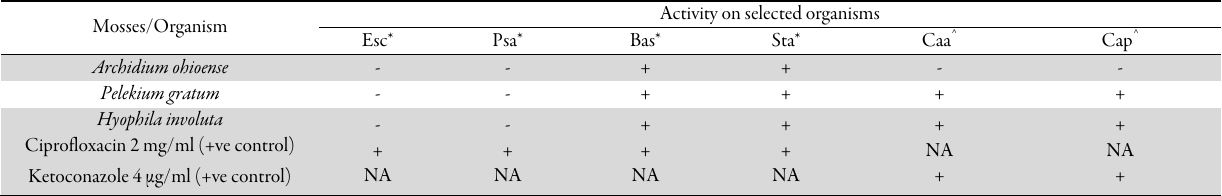
Table 3. Screening of antimicrobial activity of the schnapp extracts of Archidium ohioense, Pelekium gratum, Hyophila involuta against different microorganisms